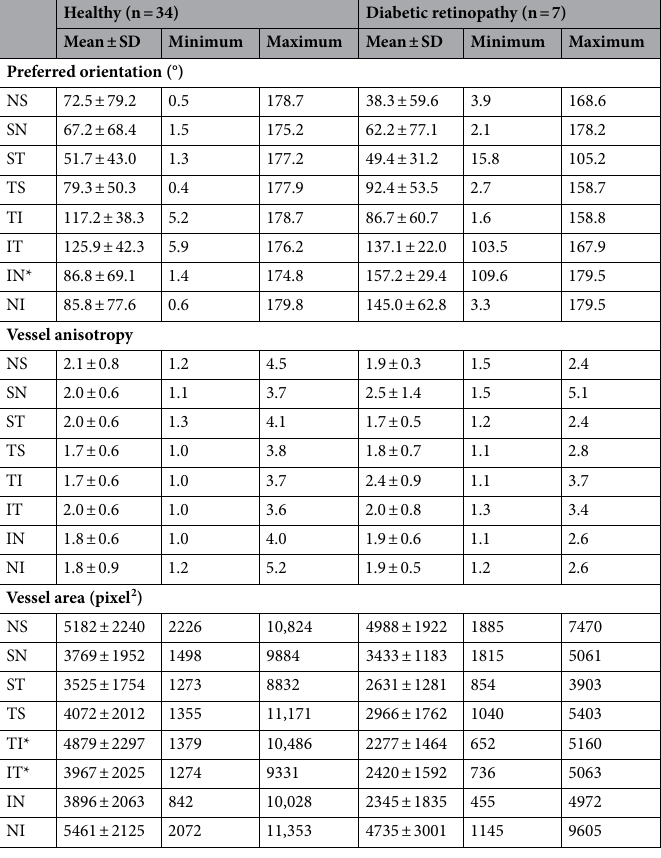
Table 1. Quantification of retinal microvascular pattern for 34 healthy and 7 DR subjects, including the average value, standard deviation and range for preferred orientation, vessel anisotropy and vessel area in each sector. Asterisk * indicates statistically significant (p < 0.05) between healthy and DR cohorts using Mann– Whitney U test. SD standard deviation.